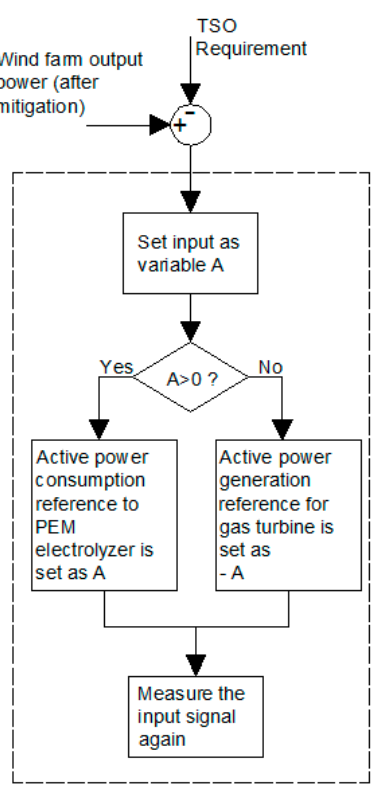
Figure 3. Coordination logic control strategy diagram.